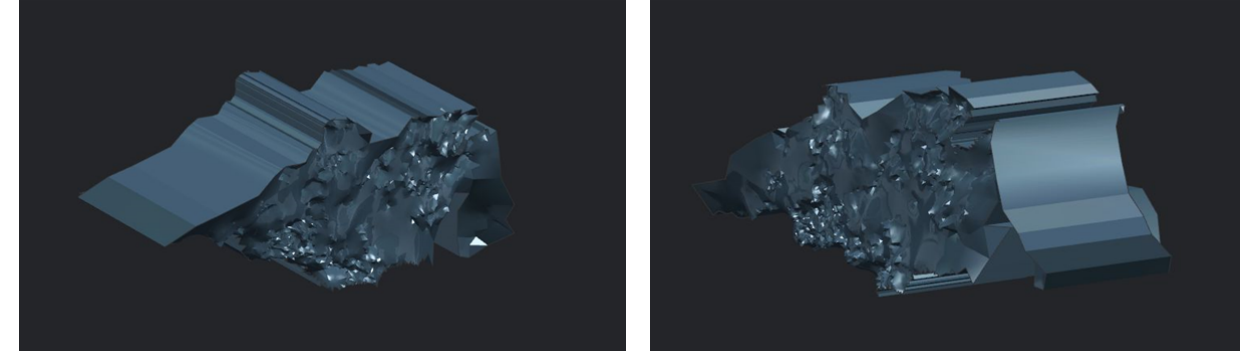
Figure 15. 3D model of confluence from left (left) side and right side (right)